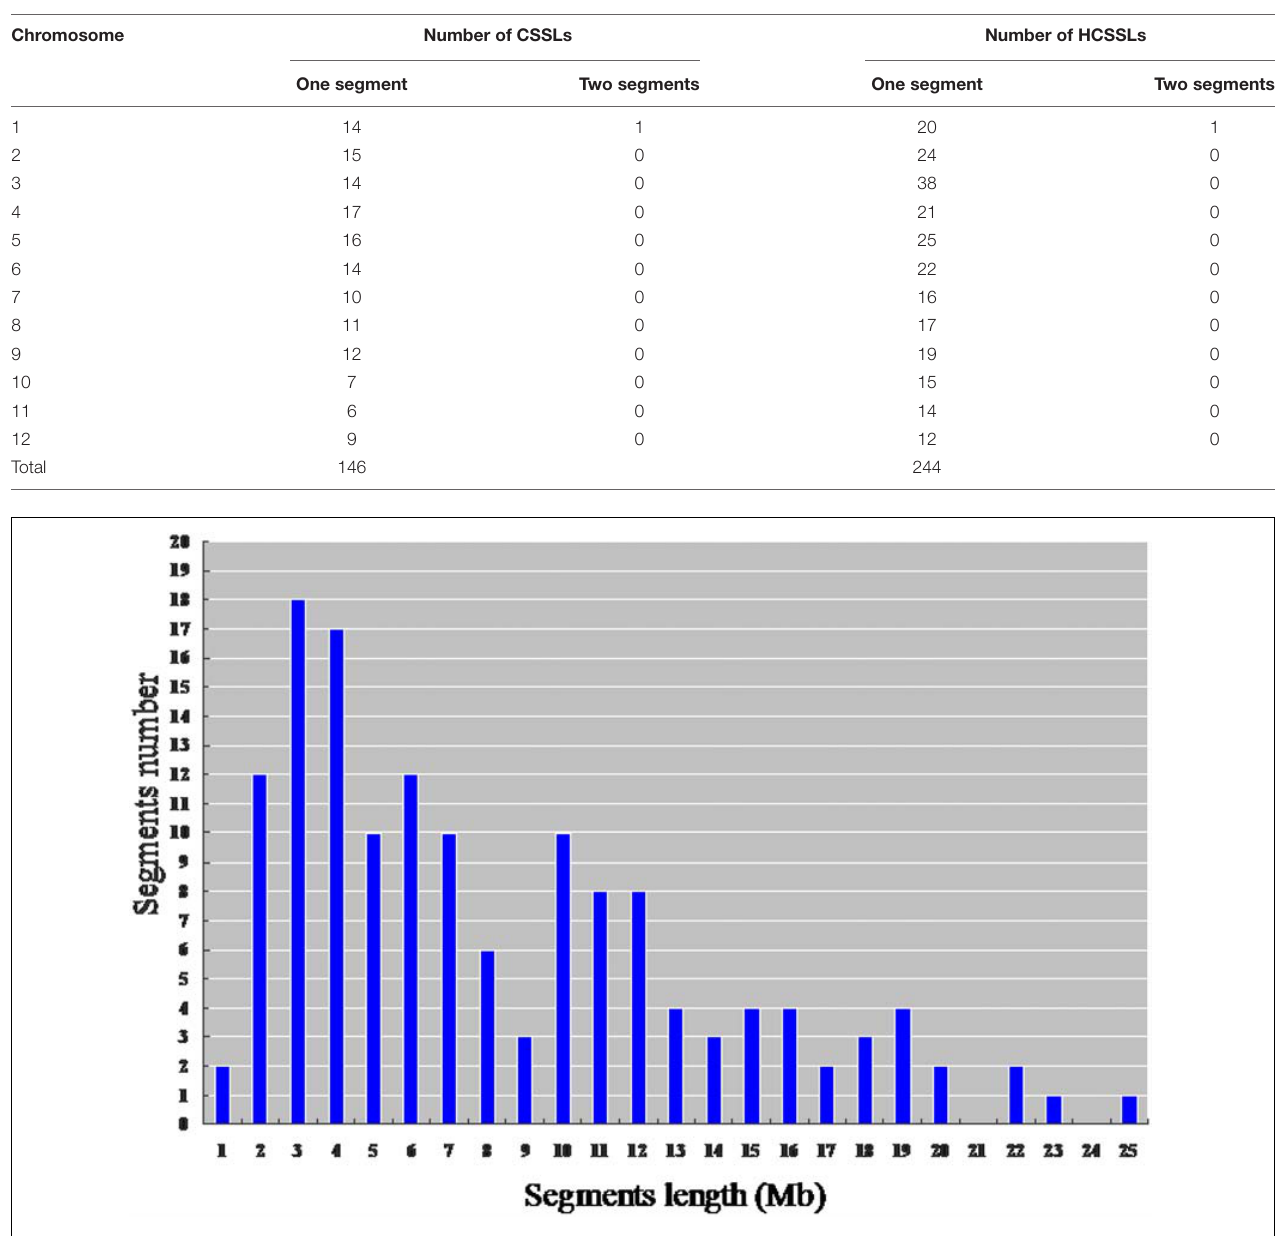
FIGURE 5 | Distribution of the length of the substituted chromosome segments in the 146 CSSLs based on the physical map constructed with molecular